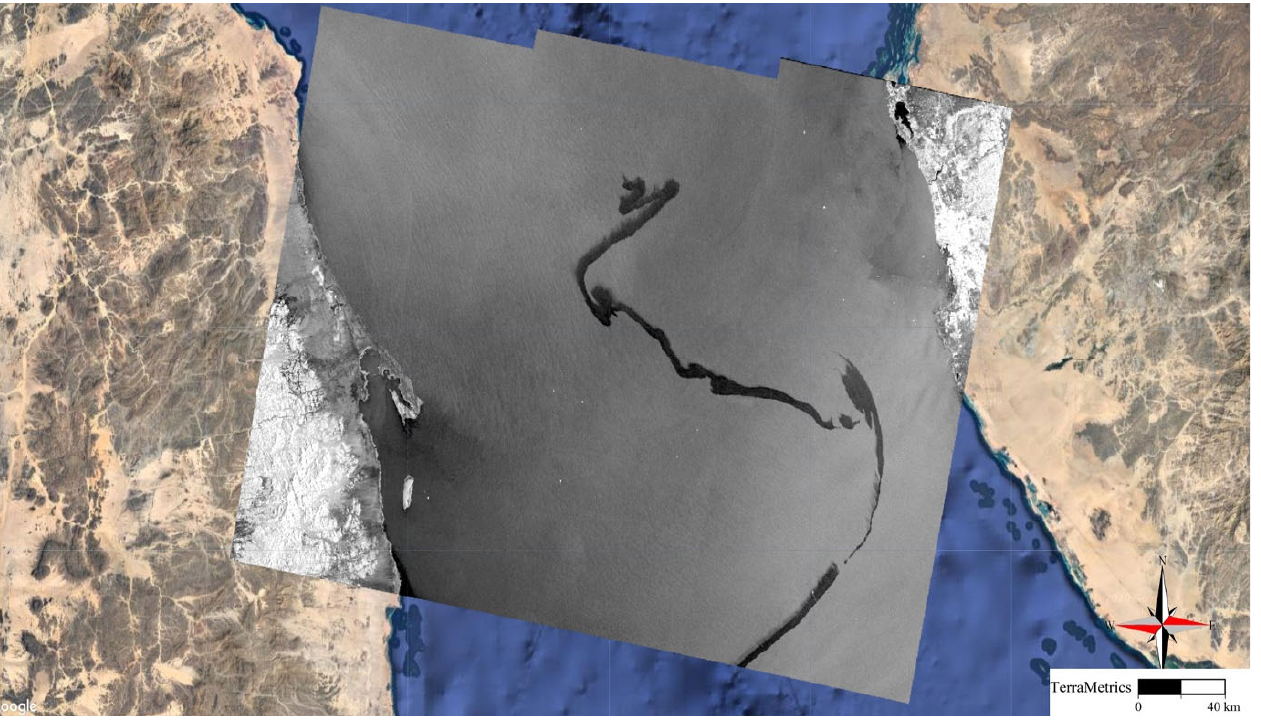
Figure 10. An OOS caused by the explosion of Sabity Oil tanker in the Red Sea. The spill looks darker than its surrounding because it has lower backscattering values. The image was acquired by Sentinel ‐ 1 on 11 October 2019.